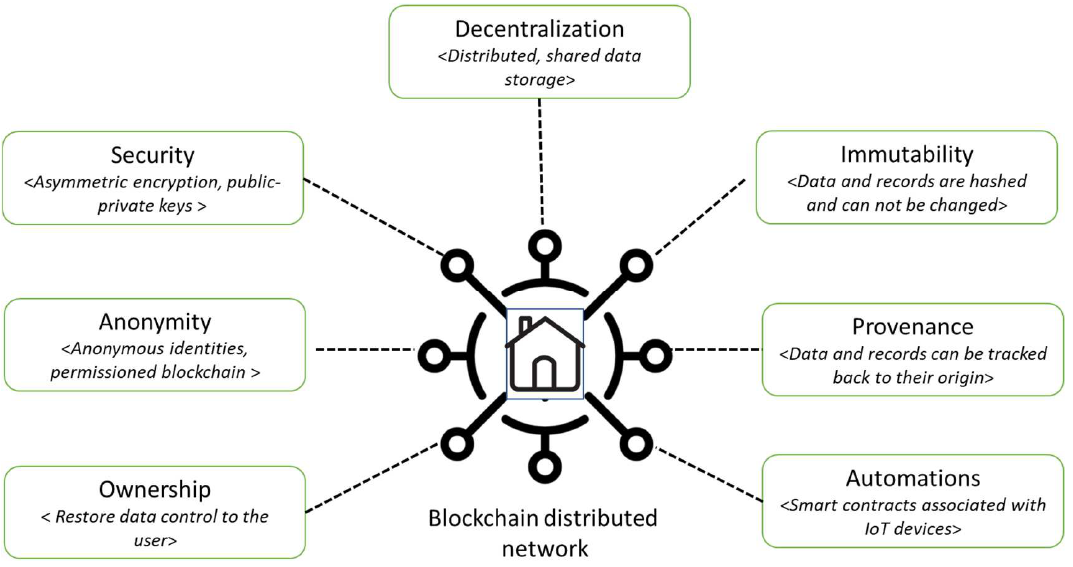
Figure 2. Features of blockchain technology desired for an ambient assisted living system.